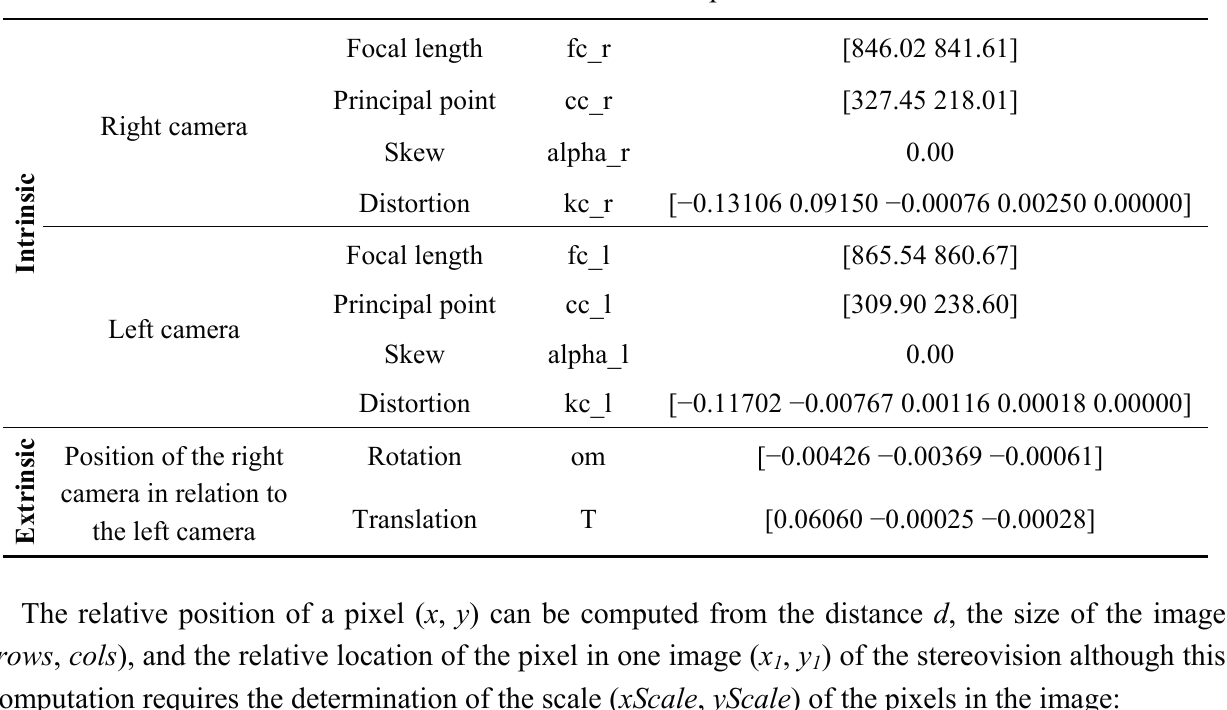
Table 5. Camera calibration